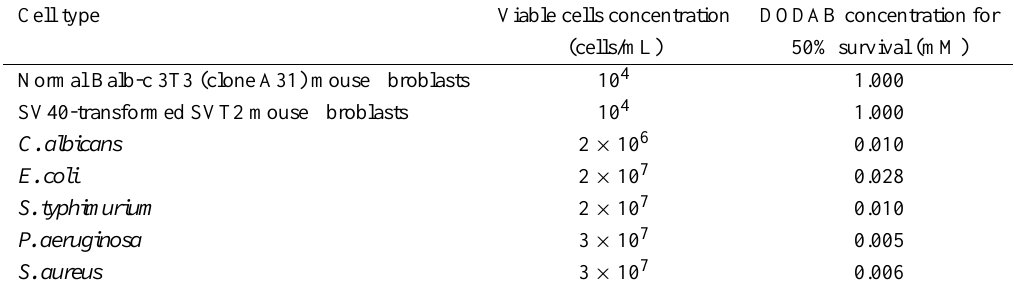
Diferential cytotoxicity of cationic DODAB liposomes. Interaction time between small DODAB vesicles and cells was fixed at 1 h. Adapted from Carmona-Ribeiro et al . 1997, Campanhã et al . 1999. Cell type Viable cells concentration Normal Balb-c 3T3 (clone A31) mouse fibroblasts SV40-transformed SVT2 mouse